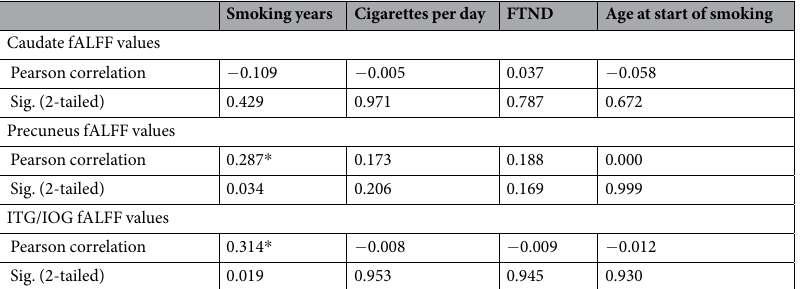
Smoking years Cigarettes per day FTND Age at start of smoking